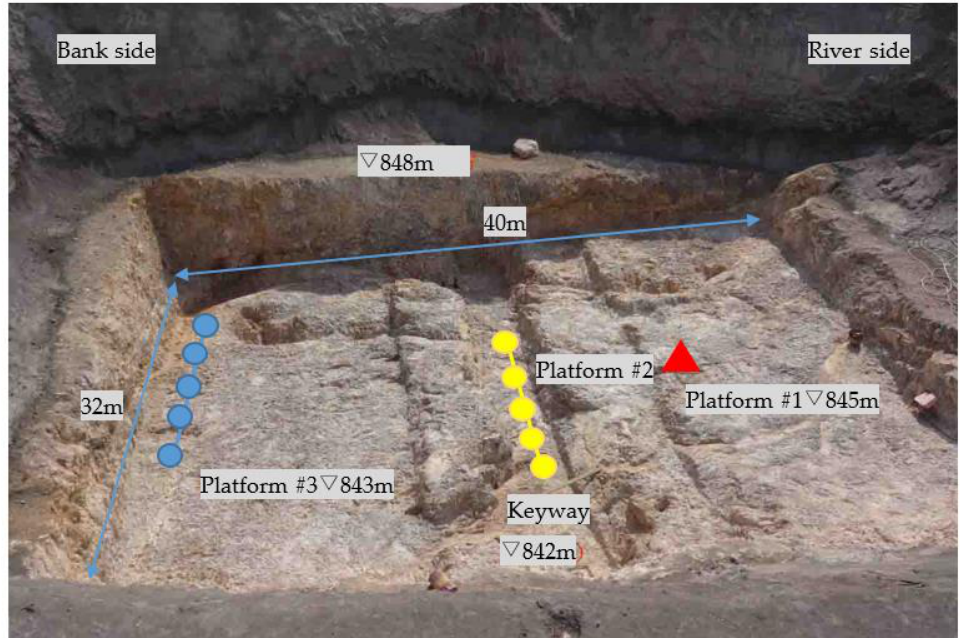
Figure 1. The rock mass foundation surface supporting the bridge anchorage. (The hollow triangle symbol in this figure stands for elevation; The red triangle is the scale model test location; The yellow dots are Location #1 for in-situ shear test and the bule dots are Location #2 for in-situ shear test).